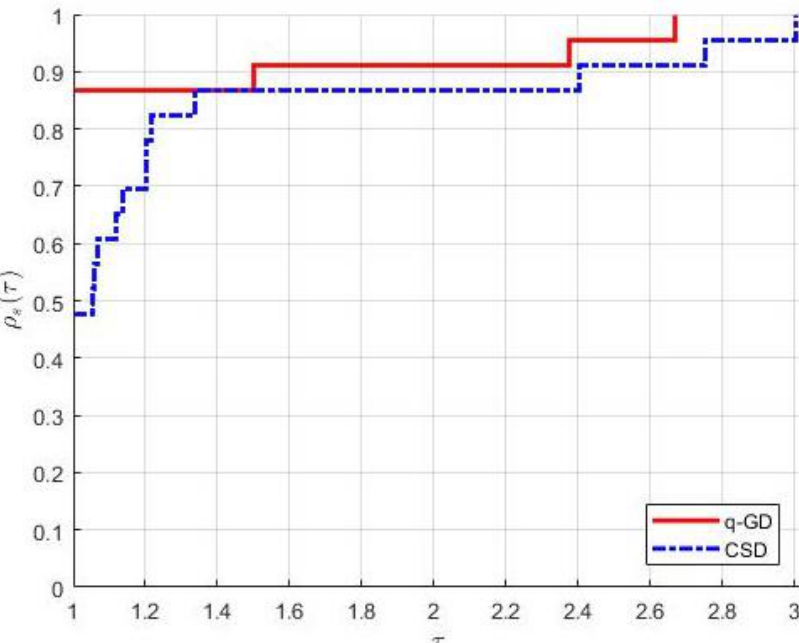
Figure 4. Performance profile for number of iterations based on Table 3.